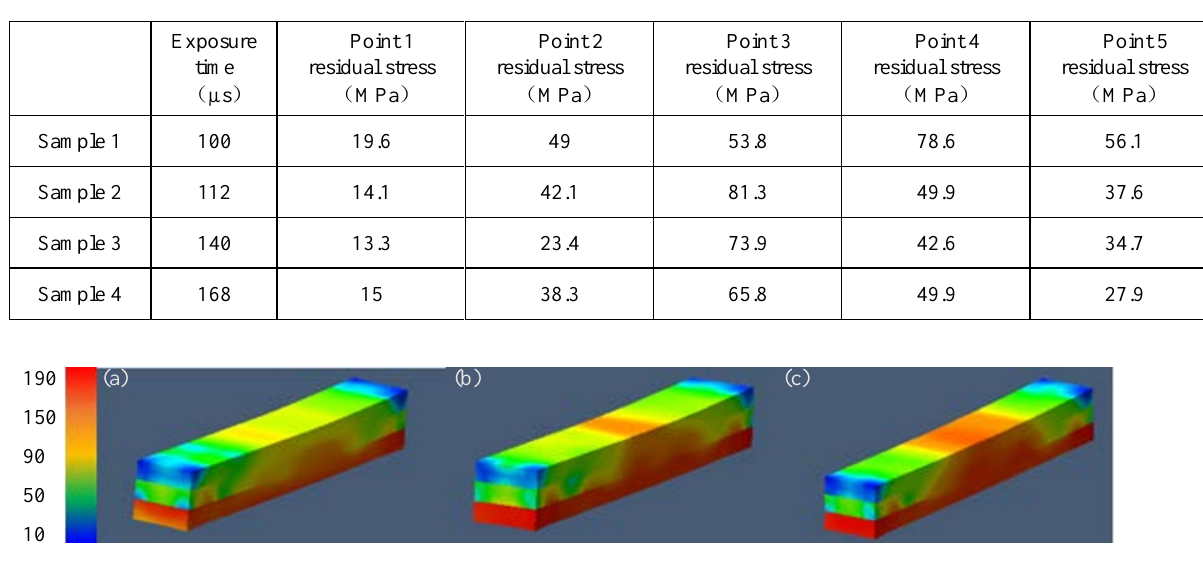
Table 3. Test of residual stress of sample